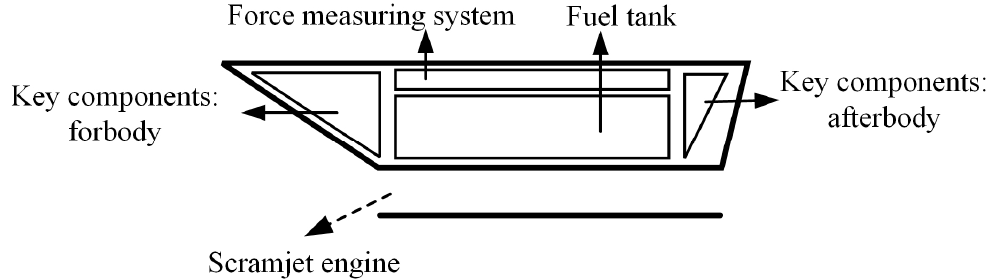
Figure 2. Inner space of air-breathing hypersonic